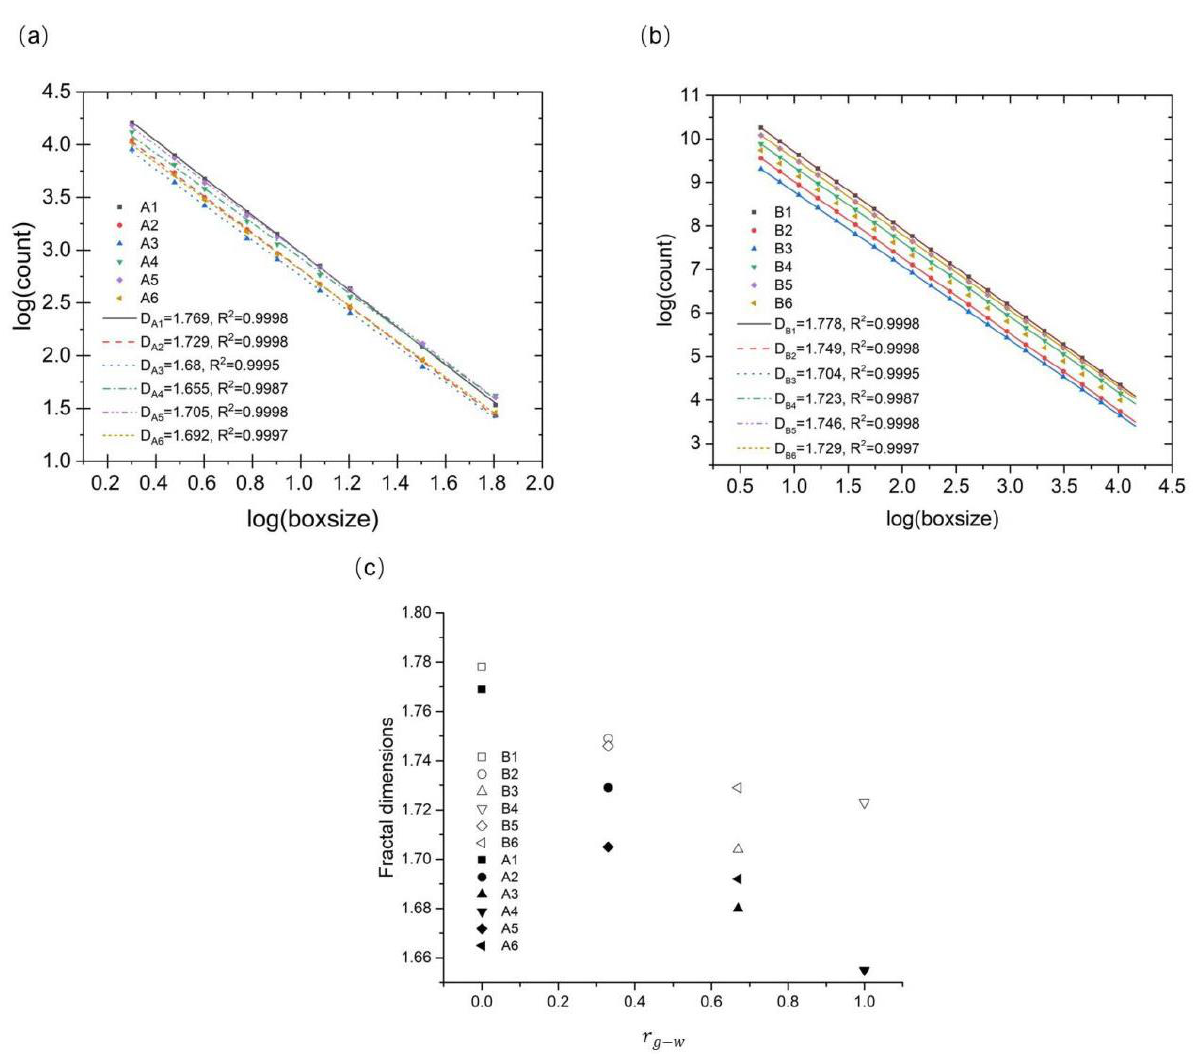
Figure 11. Fractal dimension characterization of immiscible fluid distribution in the quasi-steady state at flux rate 3 mL/min (a) and flux rate 10 mL/min (b), where the horizontal axis represents the log-arithm of box size, and the vertical axis represents the logarithm of the number of counted box-es. The slopes of the fitting lines are the fractal dimensions of flooded channels for twelve cases. R2 refers to the adjusted R-square of the fitting lines. (c) depcits the correlation between fractal dimension of fluid distribution and gas-wet area fraction.